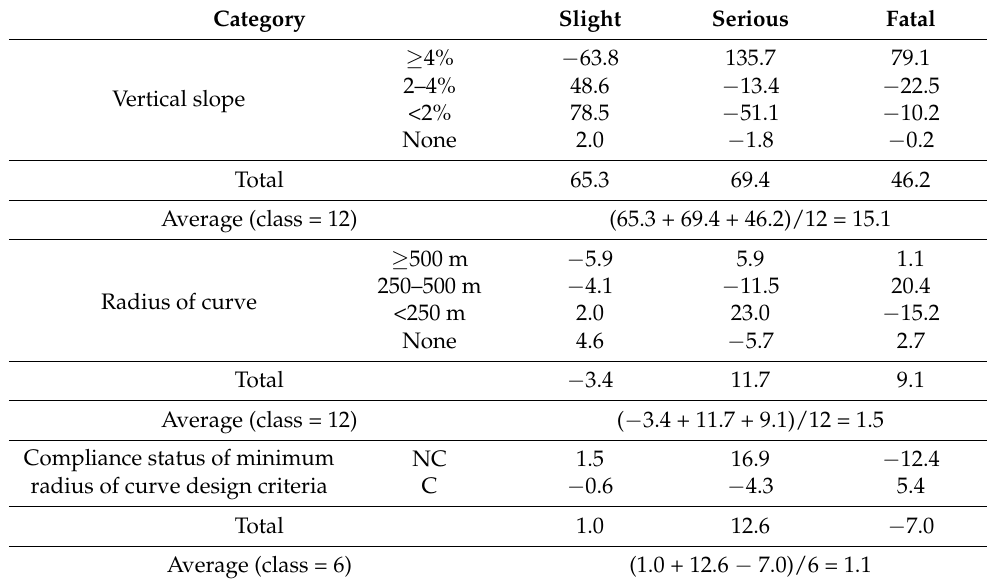
Table 5. Result of the road geometry variable threshold